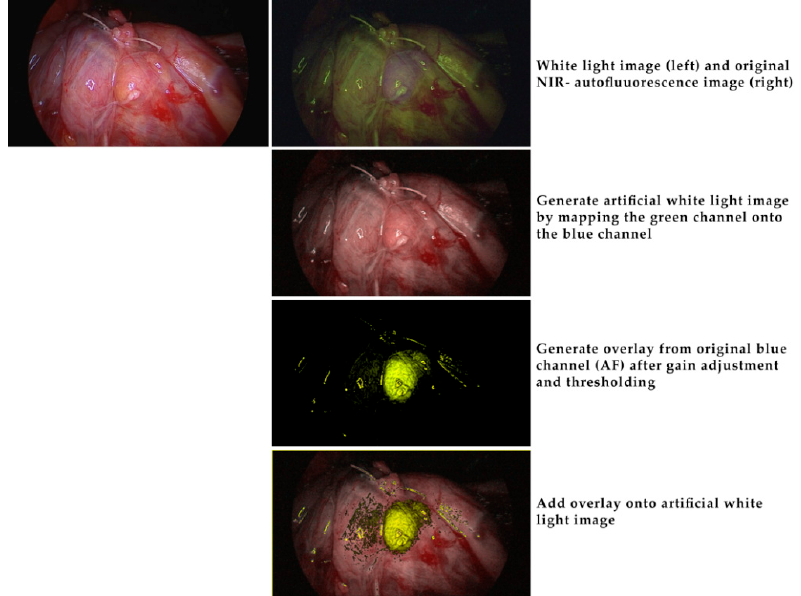
Figure 7. Offline image processing to demonstrate the potential of a future implementation of simple image processing algorithms in a real-time endoscopic NIR-autofluorescence imaging system. Top row: white light image (left) and original NIR-autofluorescence image (right) without any processing. In this image the blue channel was first replaced with the green channel and the gain of the red and green channels slightly adjusted to yield the “artificial” white light image in row 2. The original blue channel, representing the NIR, was processed as described in Figure 6 then thresholded and given a yellowish-green color (row 3). This was then overlaid to the “artificial” white light image. All processing can be implemented in a real time image processing unit.